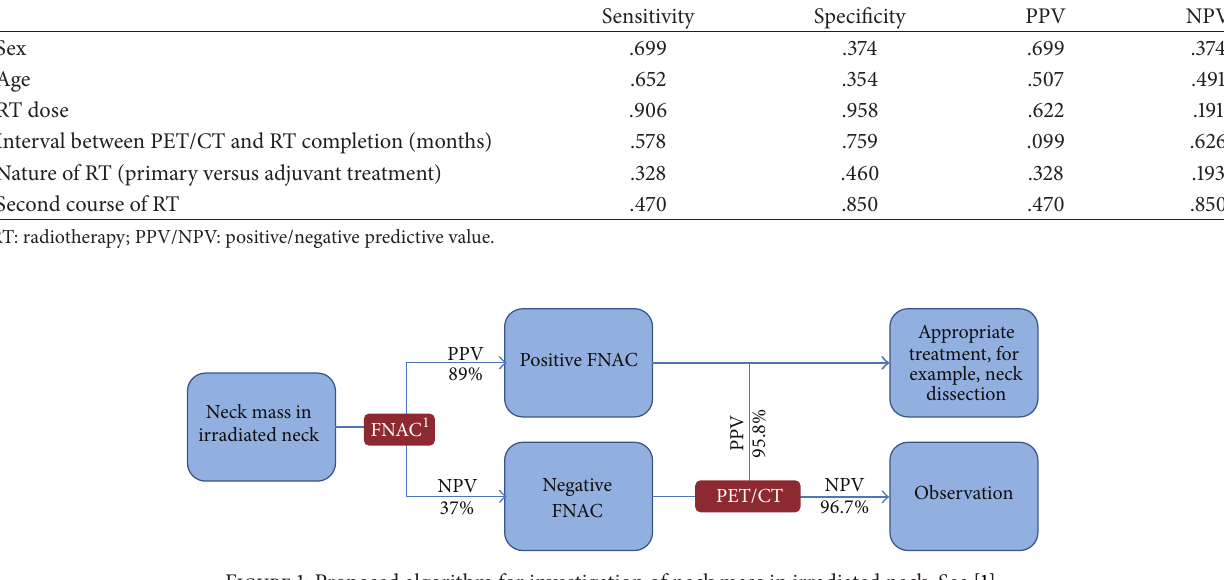
Figure 1: Proposed algorithm for investigation of neck mass in irradiated neck. See